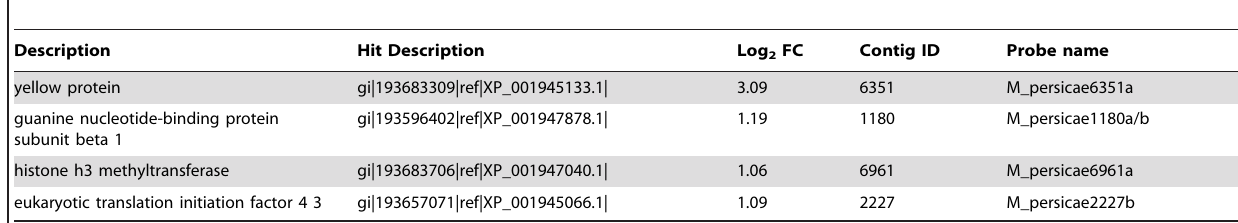
Table 4. Selected genes identified by microarray as significantly up-regulated in MR (multiple resistant) genotype in response to pirimicarb.